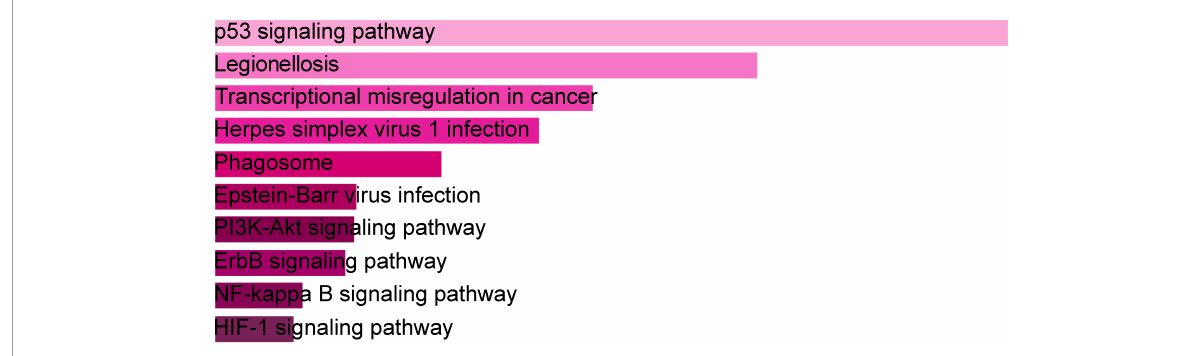
FIGURE3 The bar graphs of pathway enrichment analysis of shared DEGs among SARS-CoV-2, asthma performed by the Enricher online tool.